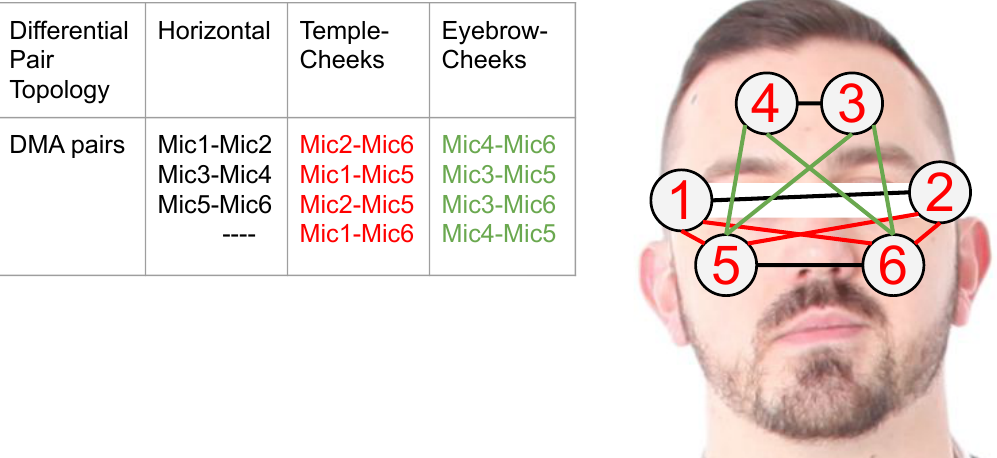
Figure 1. Pairs of Reconfigurable First Order Differential Stethoscope-Microphone Arrays To Detect Facial